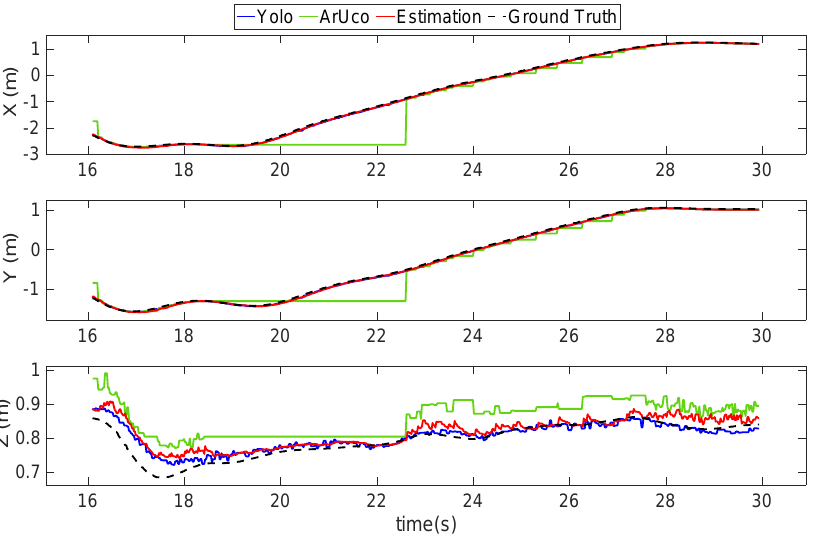
Figure 10. Flight test 2—Special case of position estimation using the proposed vision-based system to demonstrate the drawbacks of the ArUco and the advantages of the sensor fusion method.